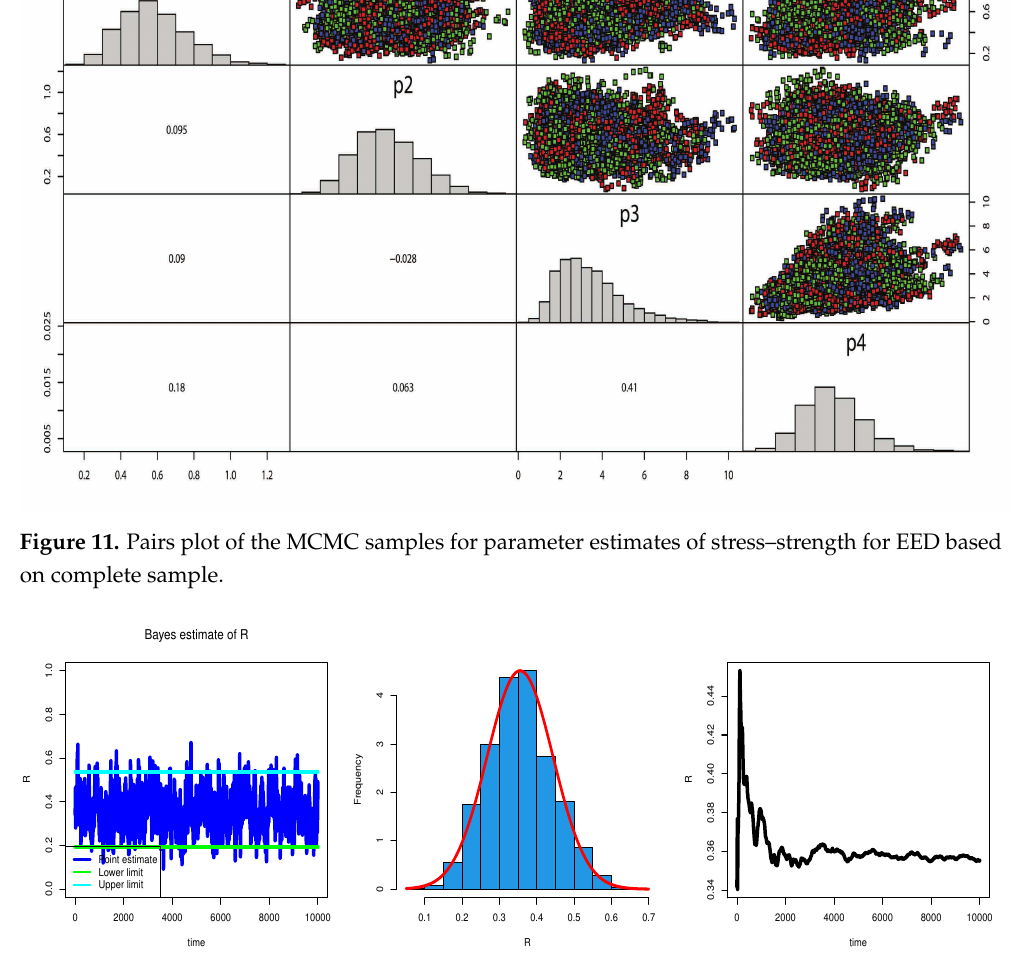
Figure 12. Trace and normal curve of posterior distribution for MCMC estimation of reliability stress–strength for EED based on censored